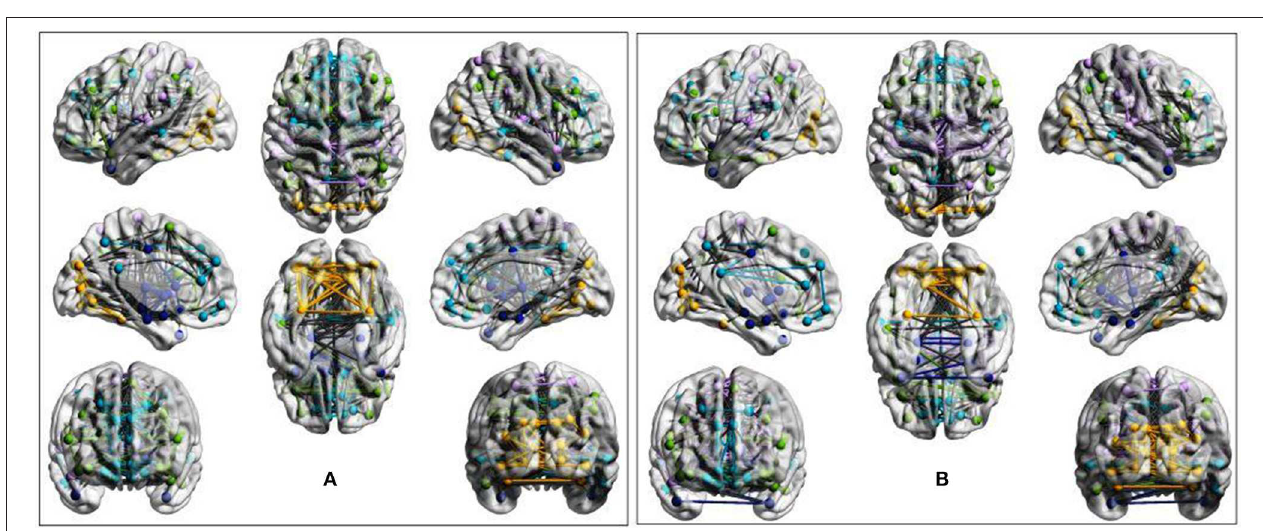
FIGURE 2 | Group-average network community pattern for the LV2 dataset at sparsity threshold T = 0.8. ROIs are defined according to the AAL90 brain atlas and colored based on community assignments by Newman’s spectral algorithm. (A) ASD cohort. (B) Control cohort. The group-level community pattern showed an overall reduction of connectivity in the brains of patients with ASD. Underconnectivity was also observed in LV1, CAL, and PIT.